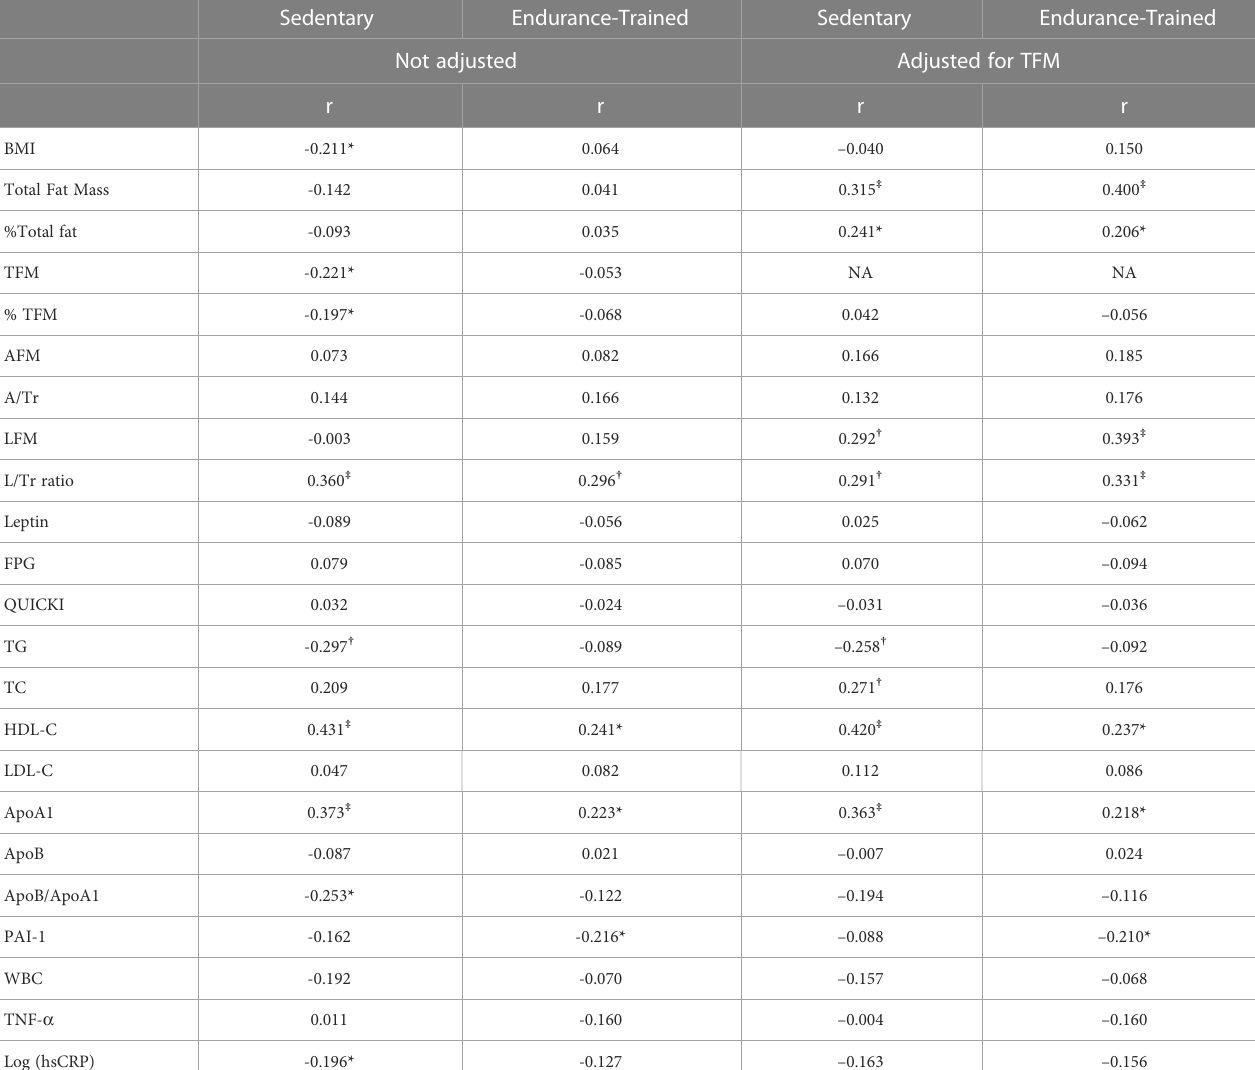
TABLE 2 Correlations of adiponectin with regional adiposity and metabolic variables in the two groups before and after adjustment for TFM. Sedentary